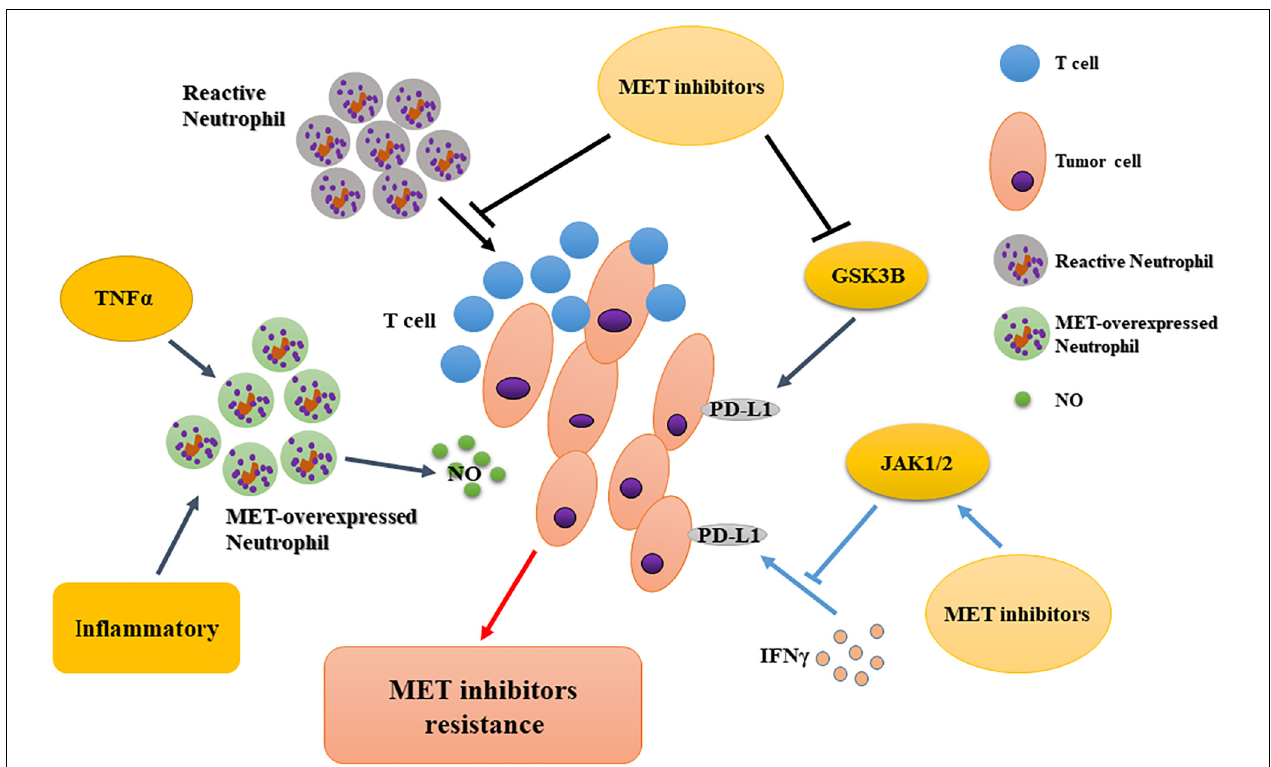
FIGURE 4 | Immunological regulation of resistance to MET-targeted therapy. MET inhibition impairs the recruitment of reactive neutrophils to tumor cells, potentiating T cell-mediated anti-tumor immunity; tumor-derived TNF α or inflammatory stimuli increase MET expression in anti-tumor neutrophils to release more nitric oxide, facilitating tumor cell killing; MET inhibitors downregulate PD-L1 expression via different signaling molecules. PD-L1, programmed cell-death ligand 1; GSK3B, glycogen synthase kinase 3 β ; JAK, Janus kinase; TNF α ; tumor necrosis factor α